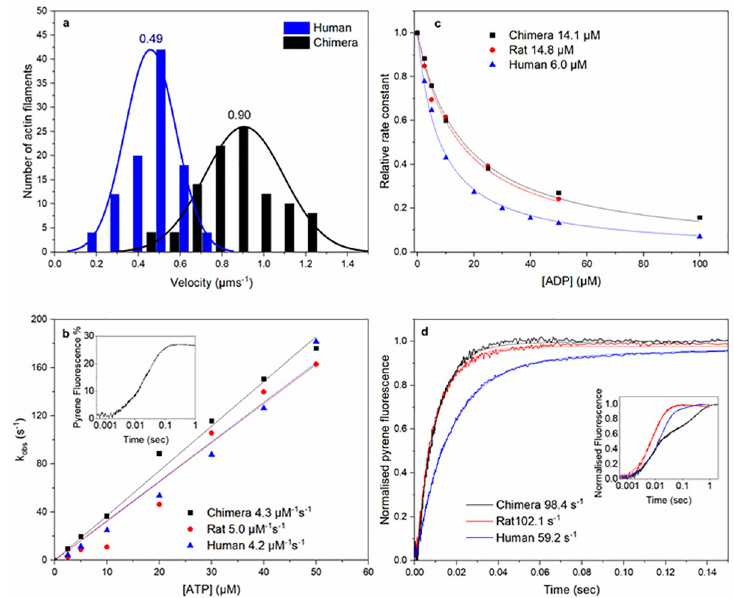
Fig 7. In vitro analysis of the chimera, rat and human β -S1 proteins. (A) Histogram of in vitro velocity of 100 rhodamine-labelled phalloidin actin filaments moving over human β -S1 or chimera S1. The solid line shows the data fitted to a single Gaussian curve. The mean velocity for the human β -S1 was 0.49 ± 0.028 μ m s − 1 and for the chimera, 0.90 ± 0.015 μ m s − 1 . (B) The effect of ATP concentration on k obs for ATP-induced dissociation of pyrene-actin.S1. The gradient generates a second-order rate constant of ATP binding; the values for the 3 proteins are highlighted next to the plot. Inset shows an example transient of 50 nM pyrene actin-chimera S1 mixed with 20 μ M ATP, resulting in a fluorescence change of 26%. (C) Plot of relative observed rate constant dependence on [ADP] for the ATP-induced dissociation of pyrene-actin.S1. A total of 50 nM pyrene-actin.S1 was mixed with 10 μ M ATP and varying [ADP] (0– 100 μ M). Numbers indicate the values of ADP affinity for acto.S1, K ADP , for the 3 proteins. (D) To measure k +ADP , ADP is displaced from pyrene-actin.S1.ADP complex by an excess of ATP. A total of 2 mM ATP was mixed with 250 nM S1 which was preincubated with 500 nM pyrene-actin and 100 μ M ADP. k +ADP values for the 3 proteins are given in 7D. Inset showing data on a longer log timescale showing the slow phase components of the transients. The average values from 3 independent measurements for experiments shown in B, C, and D are summarised in Table 3. Raw data files are available at Figshare. The inset shown in Fig 7D, a complication of the ADP displacement measurement, is that ADP displacement from human β -myosin occurs in 2 phases (fast and slow). The fast phase corresponds with ADP released at the end of the normal ATPase cycle, while the slow phase is a trapped ADP which is released much slower and at a much slower rate than the overall cycling. This is therefore a dead-end side branch of the pathway commonly seen in slow muscle and non muscle myosins [11,24,25]. The fraction of ADP trapped in this way is characteristic of each myosin. The rat β -myosin S1 has no apparent slow phase, the human has approximately 10% of ADP released in the slow phase, while the chimera has a larger fraction (approximately 40%) of the total ADP released in the slow phase. The role of the substituted amino acids in the slow phase requires further study, but the reader is referred to the literature for a broader study of this phenomena.